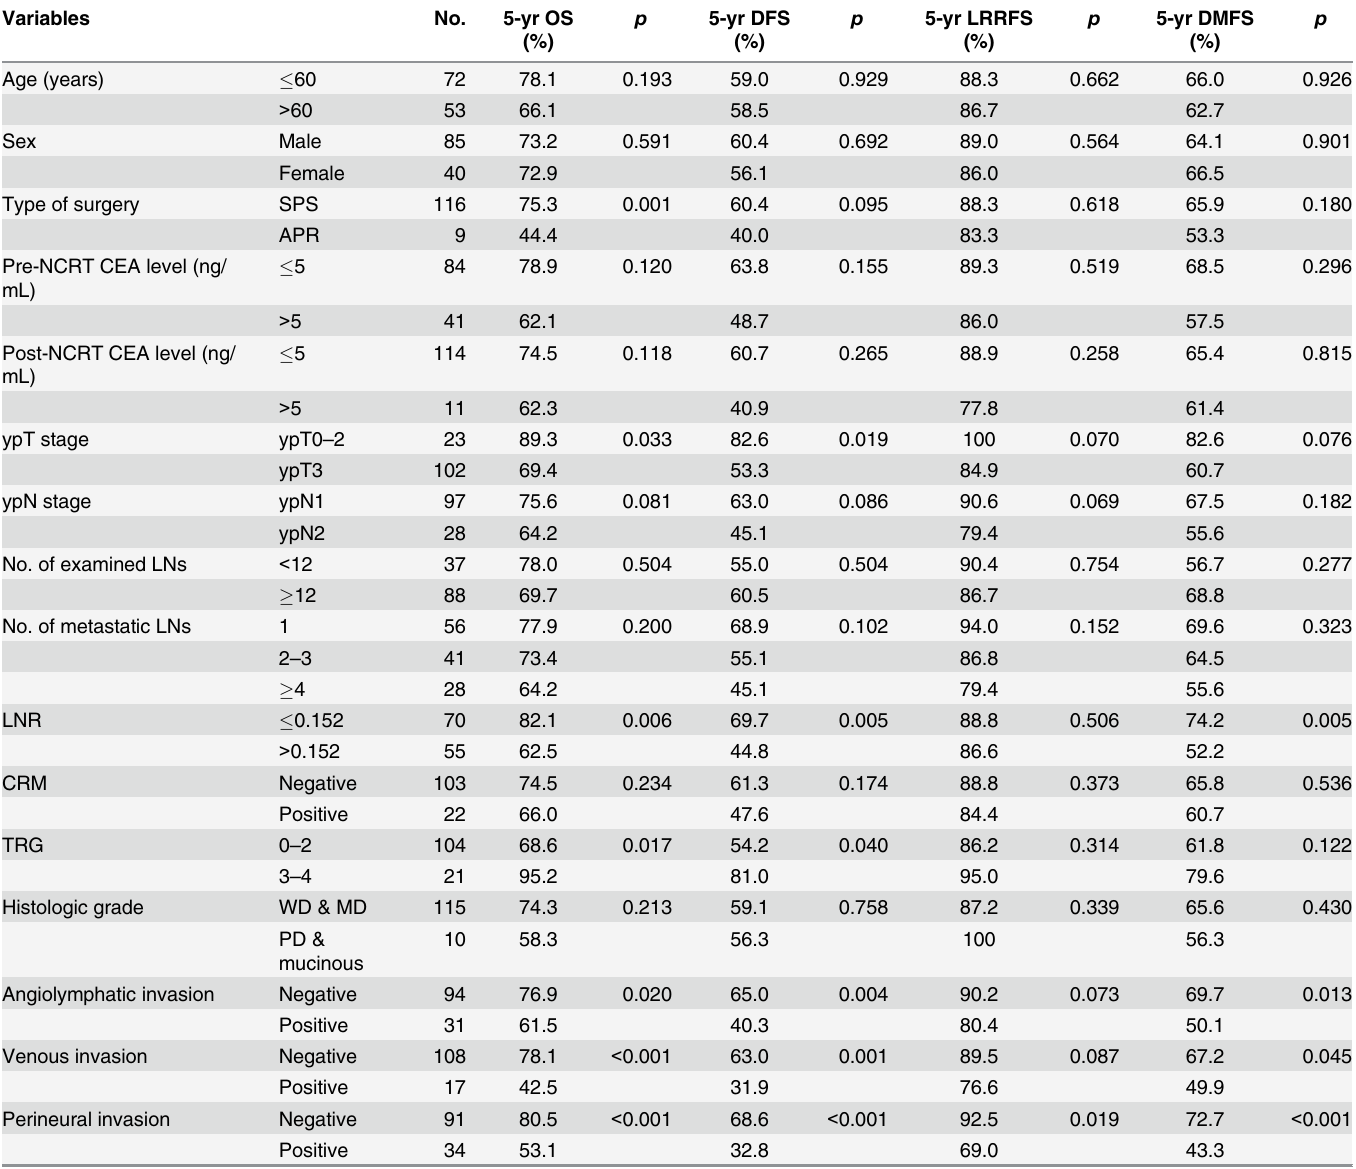
Table 2. Univariate analysis according to clinicopathologic